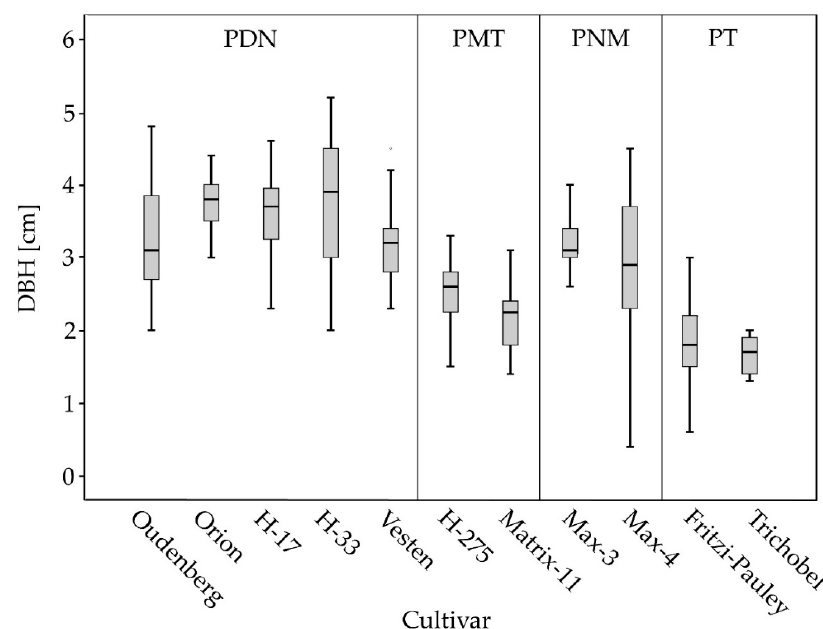
Figure 4. Box plots of DBH in Bishkek I at the end of the growing season 2019. Parentages: PDN— P. deltoides x nigra , — P. maximoviczii x trichocarpa , PNM— P. nigra x maximoviczii , PT— P. trichocarpa .